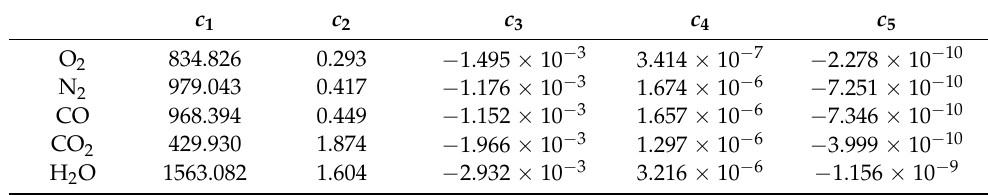
Table 2. The number of c 1 – c 5 .